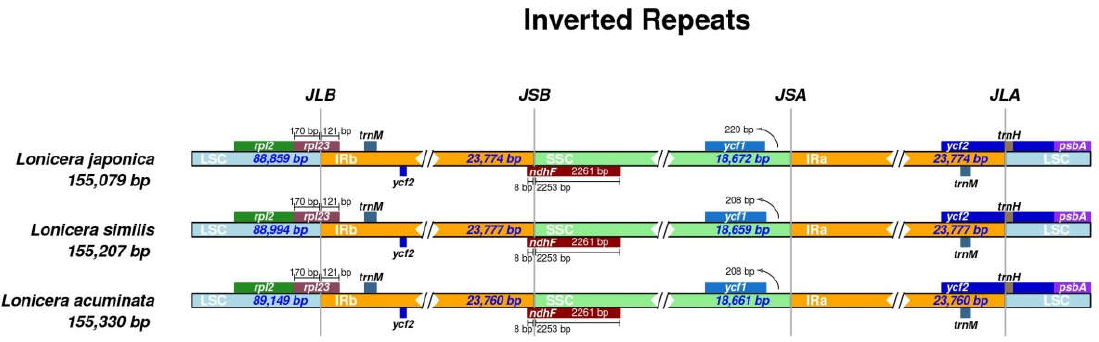
Figure 4. Comparative analyses of the boundary regions (LSC, SSC, and IR) among three chloro‑ plast genomes of Lonicera . Gene names are indicated in boxes, and their lengths in junction sites are displayed above the boxes.